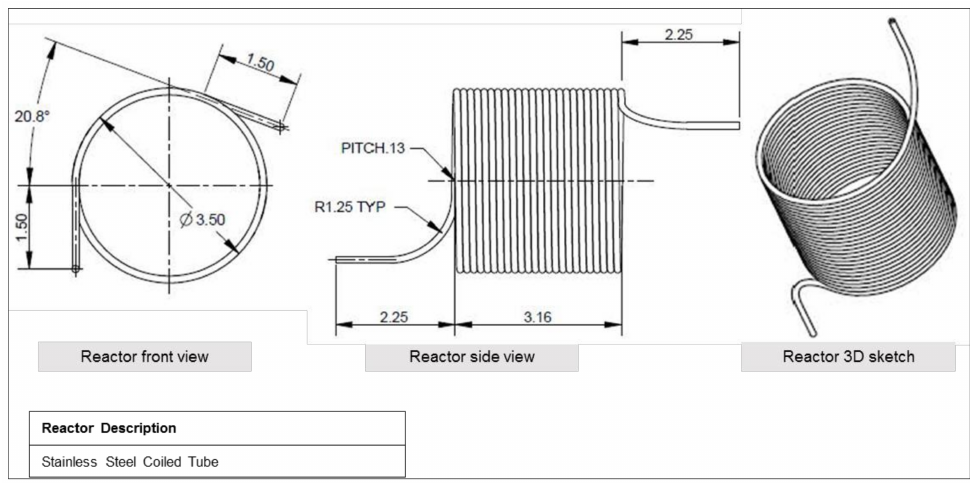
Figure 12. Reactor dimension.